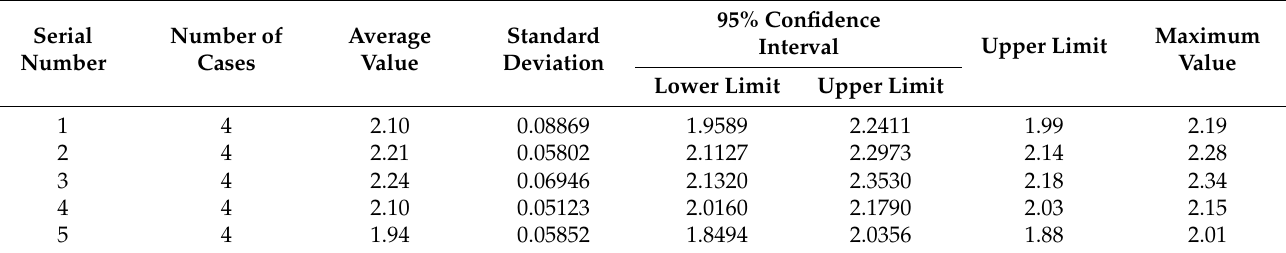
Table 10. Time statistics of each channel.